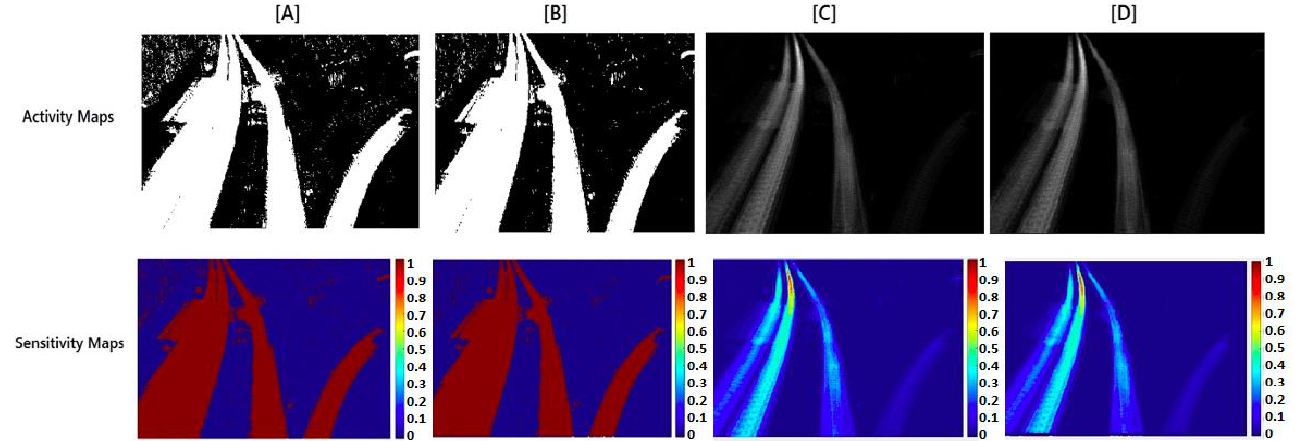
Figure 5. Activity map and pixel sensitivity maps of video dataset 1 by different approaches: ( A ) by Pan et al. in [12]; ( B ) by Mehboob et al. in [13]; ( C ) by Indu, S. in [14]; ( D ) our proposed framework.